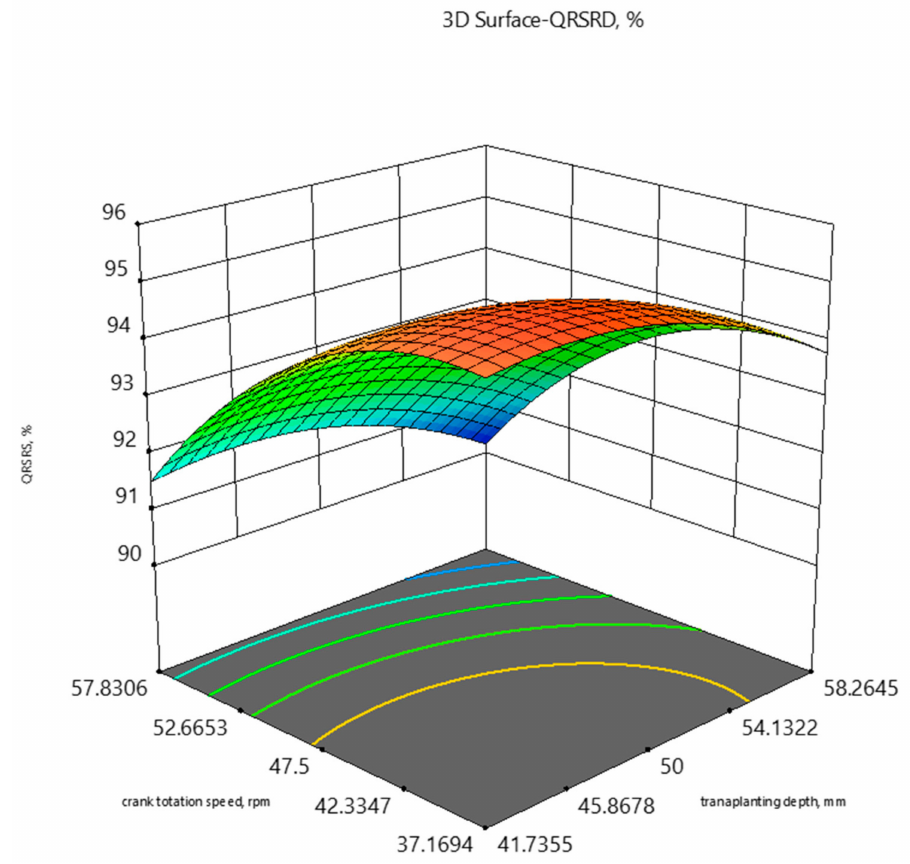
Figure 14. The interaction of transplanting depth and crank rotation speed on